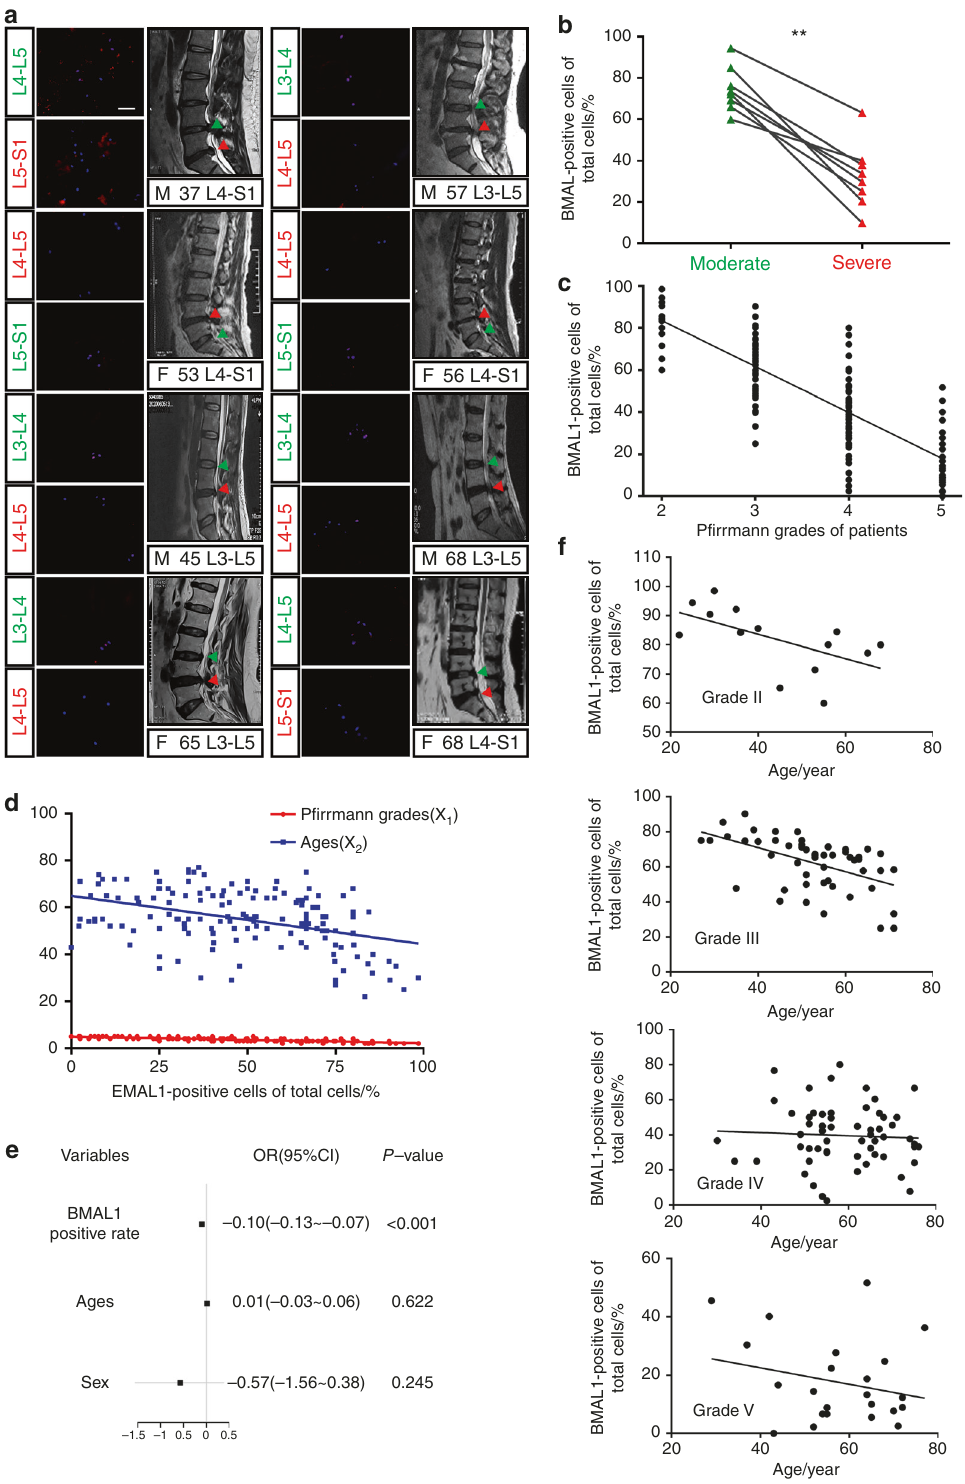
Fig. 1 BMAL1 shows a negative correlation with the degree of IDD. a Immuno fl uorescence of BMAL1 in 8 pairs of human NP samples with different IDD severities from each patient. Scale bar: 50 μ m. Green triangles: IVDs with moderate IDD severity; red triangles: IVDs with severe IDD severity. n = 8. b Quanti fi cation of the percentage of BMAL1-positive cells in 8 pairs of human NP samples with different IDD severities from each patient. Paired Student ’ s t test. c Single-factor linear regression analysis of the relationship between the percentage of BMAL1- positive cells and P fi rrmann grades based on 149 NP samples. d Multivariate linear regression analysis of the relationship between all variables (P fi rrmann grades and ages) and the percentage of BMAL1-positive cells. e Logistic regression analyses for the relationship between all variables (BMAL1 positive rate, sex and age) and IDD severity. f Single-factor linear regression analysis of the relationship between the percentage of BMAL1-positive cells and age for NP tissues of similar P fi rrmann grades. ** P <